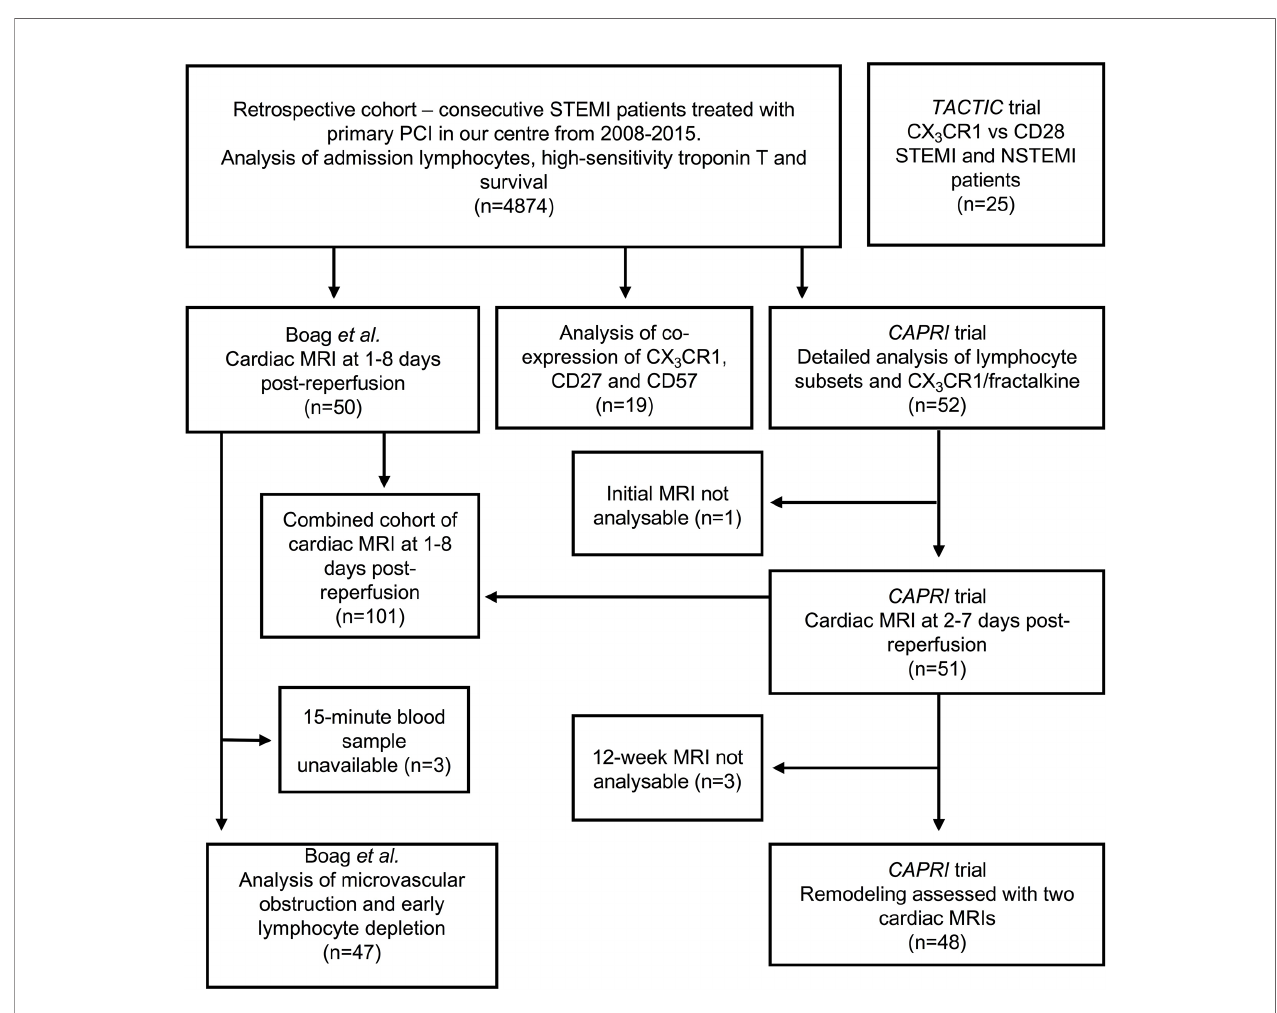
FIGURE 1 | Overview of patients with acute MI used in this study. Three of the four prospective cohorts were recruited between 2008 and 2015, so these patients are also included in the retrospective analysis. The TACTIC trial recruited patients after 2015, so these are not included in the retrospective cohort. cMRIs were unanalysable either because of technical problems with the scanner or poor image quality (e.g. due to atrial fi brillation). Acute cMRIs from Boag et al. and CAPRI were analysed together. We also describe data from 10 healthy control patients, and 21 explanted human hearts, not shown in this